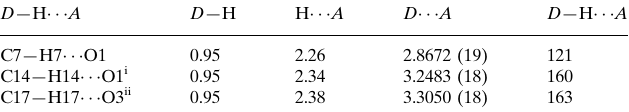
Hydrogen-bond geometry (A˚ , (cid:1)